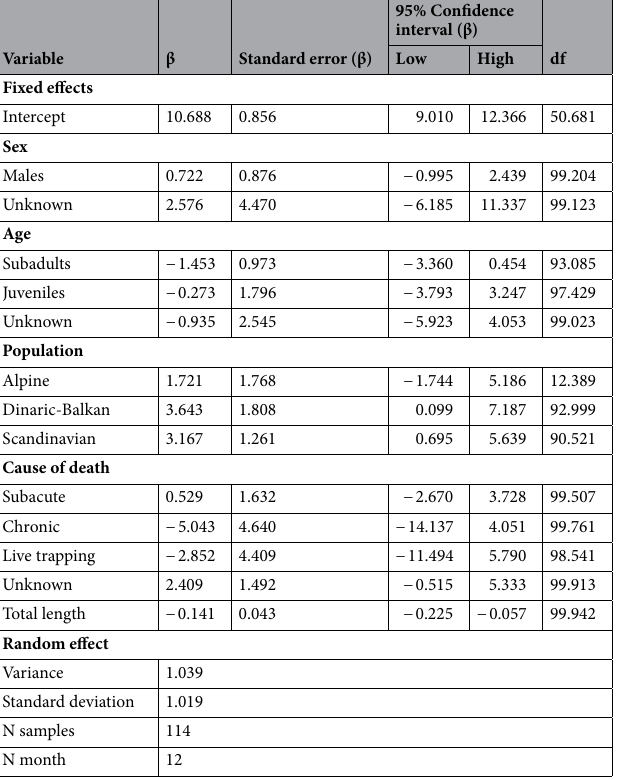
Table 2. Summary of the most supported linear mixed model of the determinants of hair cortisol concentration. Results from Model 1 in Table